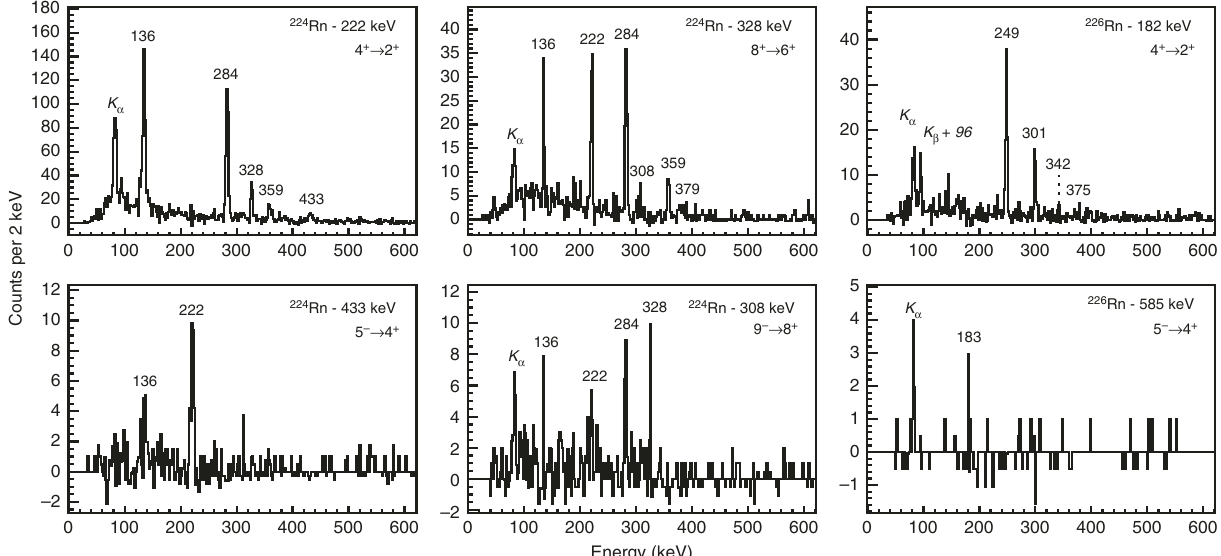
Fig. 2 Coincidence γ -ray spectra. The representative background-subtracted γ -ray spectra are in time-coincidence with different gating transitions. Here the observed peaks are labelled by the energy (in keV) of the transition. The gating transition is additionally labelled by the proposed spin and parity of the initial and fi nal